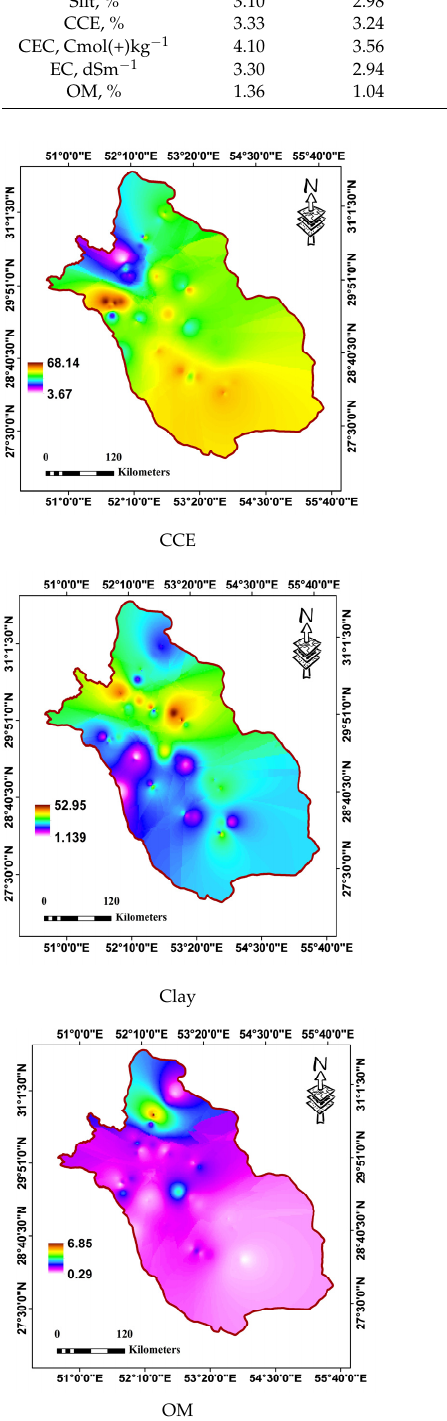
Figure 3. Interpolation maps of soil parameters by kriging method (circular model). Next, the capability of linear functions to calculate the fuzzy memberships was examined for prediction of the different KSP conditioning factors in ArcGIS 10.2 (extension of spatial data modeller